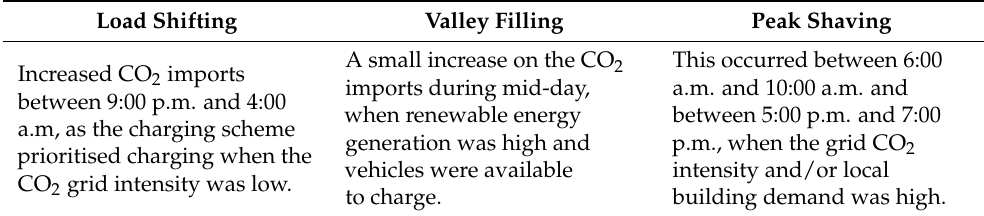
Table 14. Observed benefits of